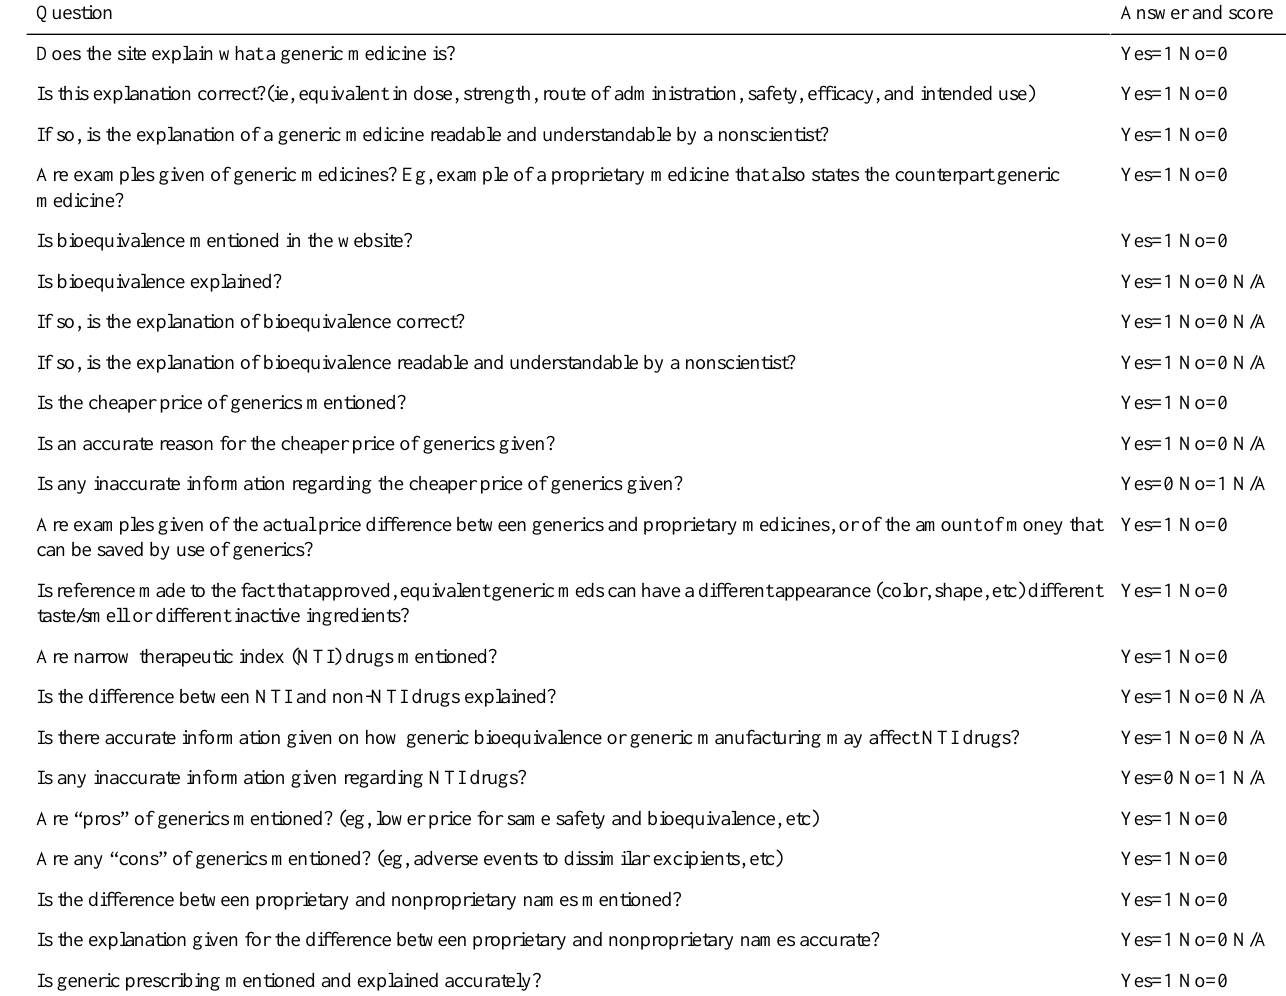
Table 1. Website Quality Assessment for assessing information on websites on generic medicines.